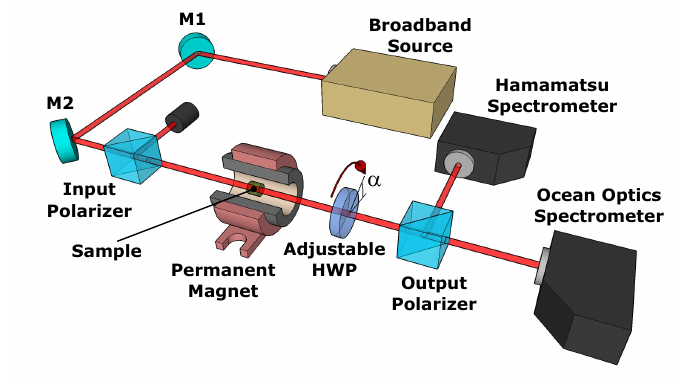
Figure 2. Experimental setup for the Faraday rotation dispersion